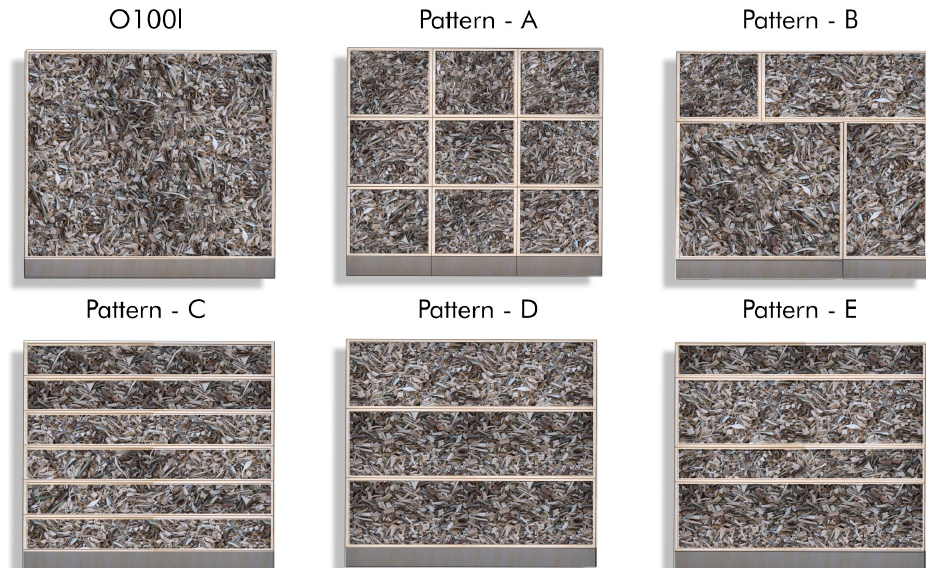
Figure 4. 3D modeling and rendering of the possible patterns composed of the birch plywood frame sub-modules with olive wood chips as the filler material.